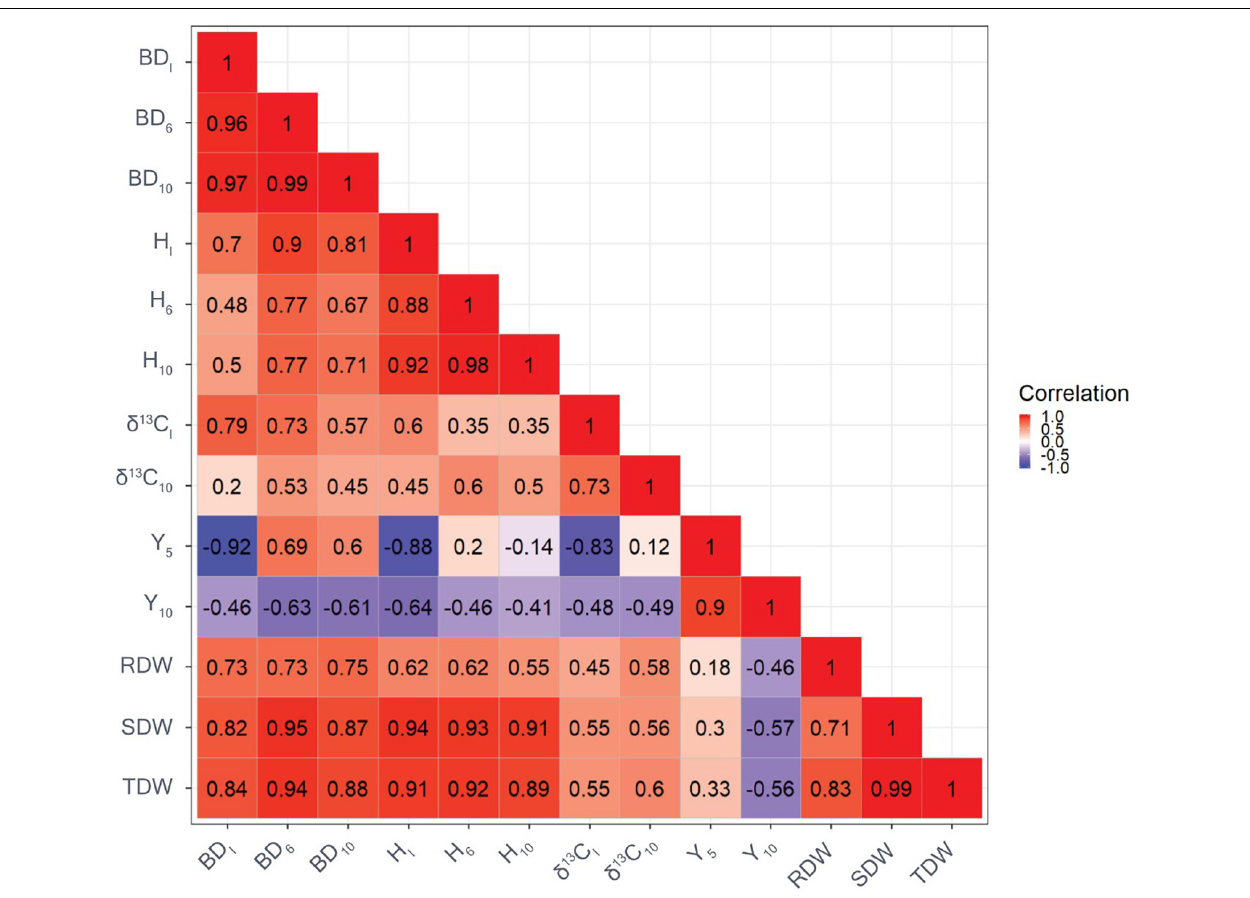
FIGURE 2 | Genetic correlations among growth traits, carbon isotope composition δ 13 C based on GBLUP (the reddish the color, the greater value of genetic correlation). BD I is the initial basal diameter before water stress, BD 6 is basal diameter after 6 months of water stress, BD 10 is basal diameter after 10 months of water stress, H I is initial height before water stress, H 6 is height after 6 months of water stress, H 10 is height after 10 months of water stress, δ 13 C I is initial needle δ 13 C before water stress, δ 13 C 10 is final needle δ 13 C after 10 months of water stress, Y 5 is maximum quantum yield of PSII after 5 months of water stress, Y 10 is maximum quantum yield of PSII after 10 months of water stress, RDW is the root dry weight after harvesting, SDW is shoot dry weight after harvesting, and TDW is total dry weight after